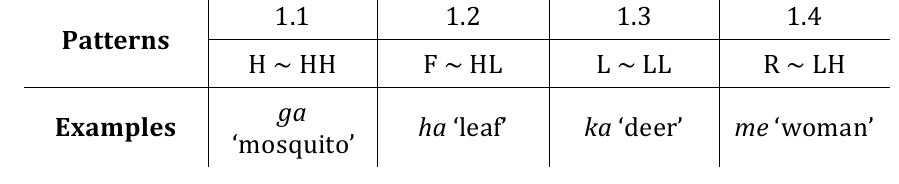
Table 2: Japanese pitch accent in monosyllabic